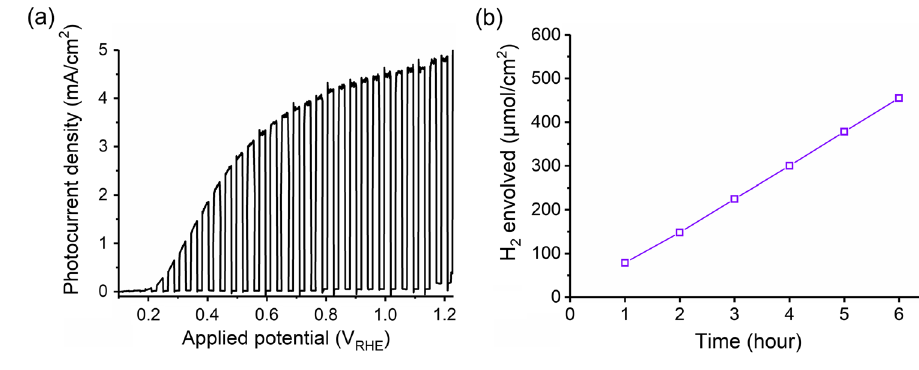
Fig. 5 Photoelectrochemical performance of BiVO film in a 4 0.1 M potassium phosphate (KPi) and 0.1 M Na SO solu- 2 3 tion. a Photocurrent densities at 0–1.2 V ; b evolved H RHE